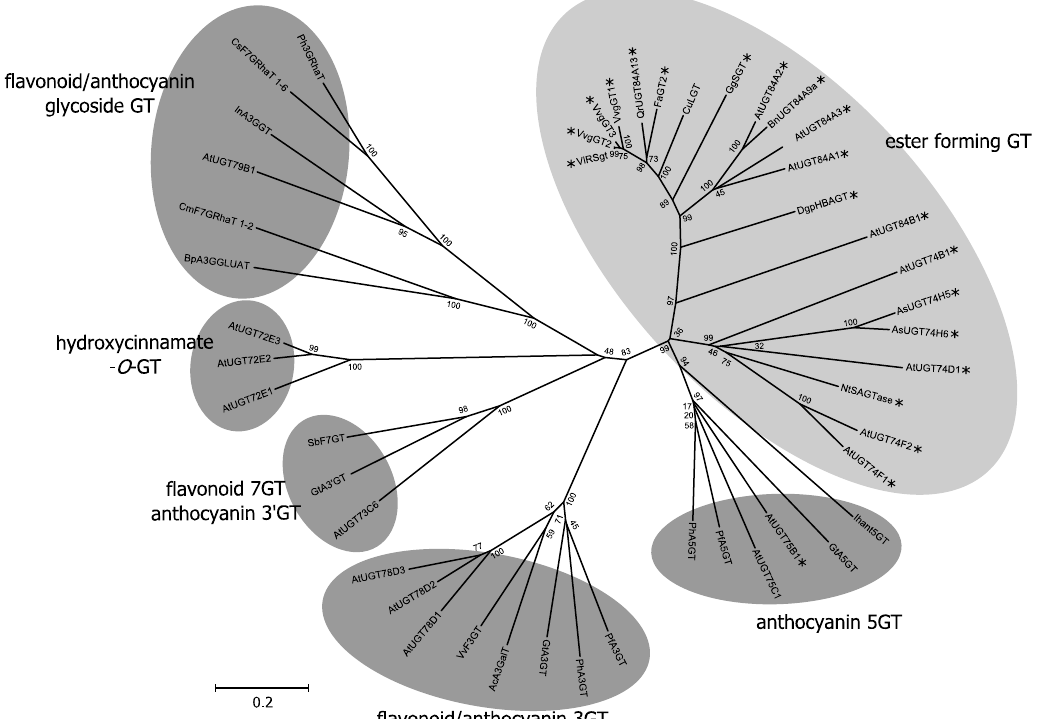
Figure 5. Phylogenetic tree analysis of UGTs mediating acyl-glucose production. The tree was constructed from multiple amino acid sequences using the Neighbor-Joining algorithm. The clade of the UGTs involved in acyl-glucose biosynthesis is shown with a gray circle and the others with dark gray circles. UGTs that exhibit acyl-glucose synthesis activity in vitro are marked with